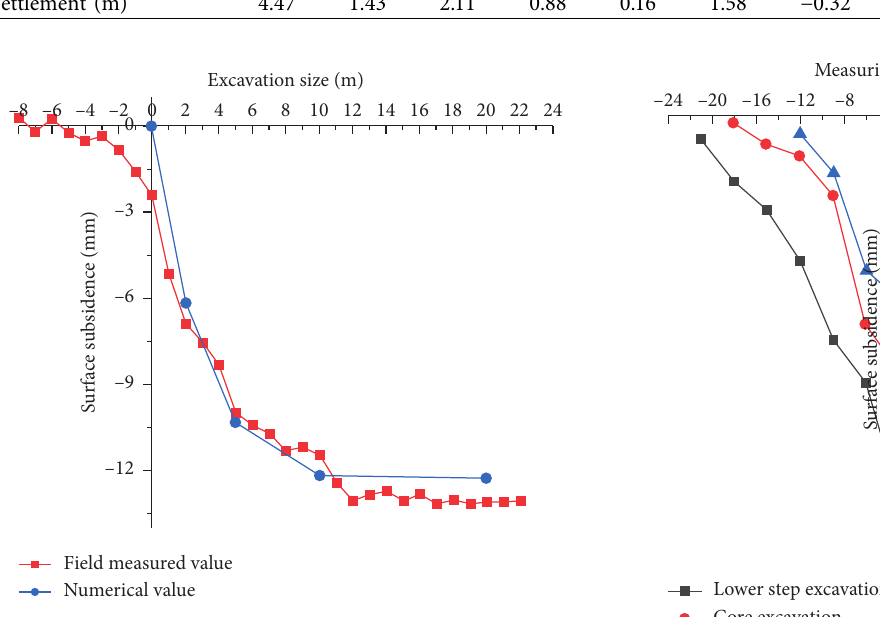
Figure 14: Time history curve of surface settlement caused by tunnel excavation.